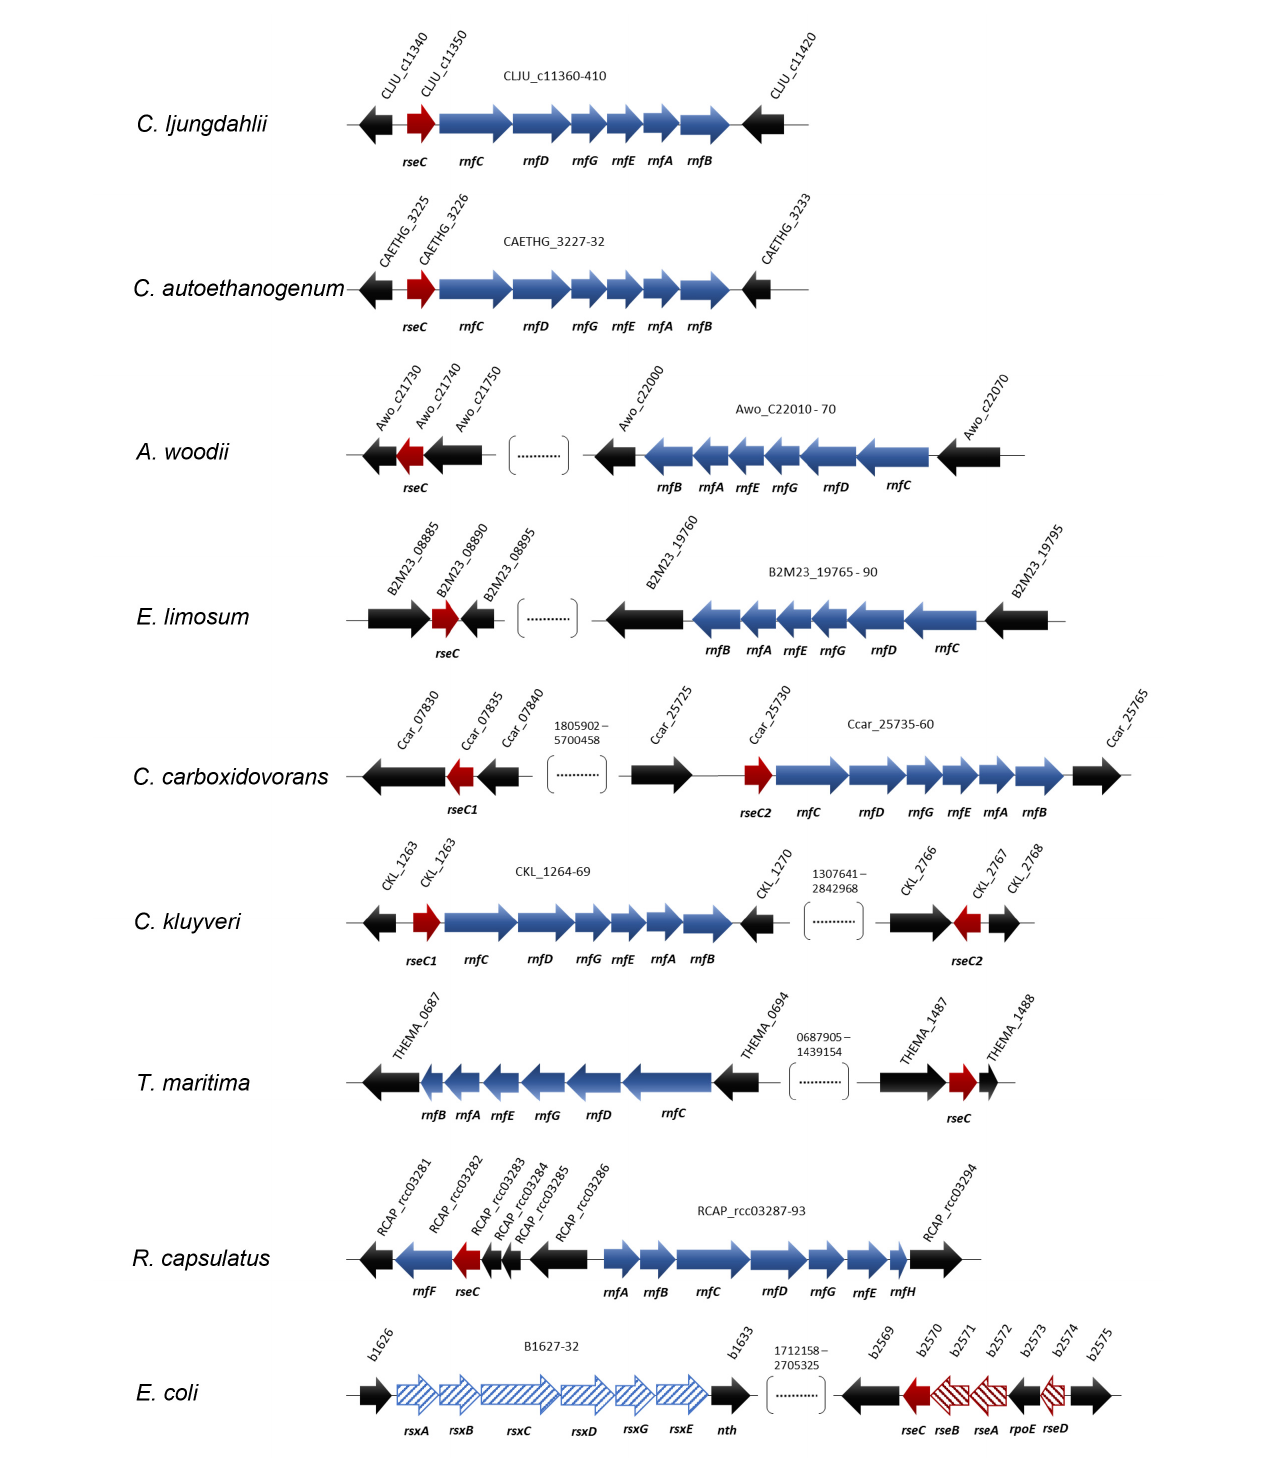
FIGURE 4 | Location and orientation of rseC genes in model microbes that possess RNF complex gene clusters. The conserved protein domain RseC_MucC (pfam04246) was identified in the rseC protein sequence of C. ljungdahlii and used to search for putative rseC genes in the genome of C. autoethanogenum, A. woodii , E. limosum, C. carboxidovorans, C. kluyveri, T. maritima, R. capsulatus, and E. coli . All sequence analyses and gene arrangements were adapted from the JGI platform and the NCBI database (03/2021). The type strains are listed in Table 3 . In red, putative rseC genes; in red pattern fill, rseC -associated genes in E. coli ; in blue, RNF-complex gene cluster; in blue pattern fill, rsx genes, which are homologous to the rnf genes in R. capsulatus.